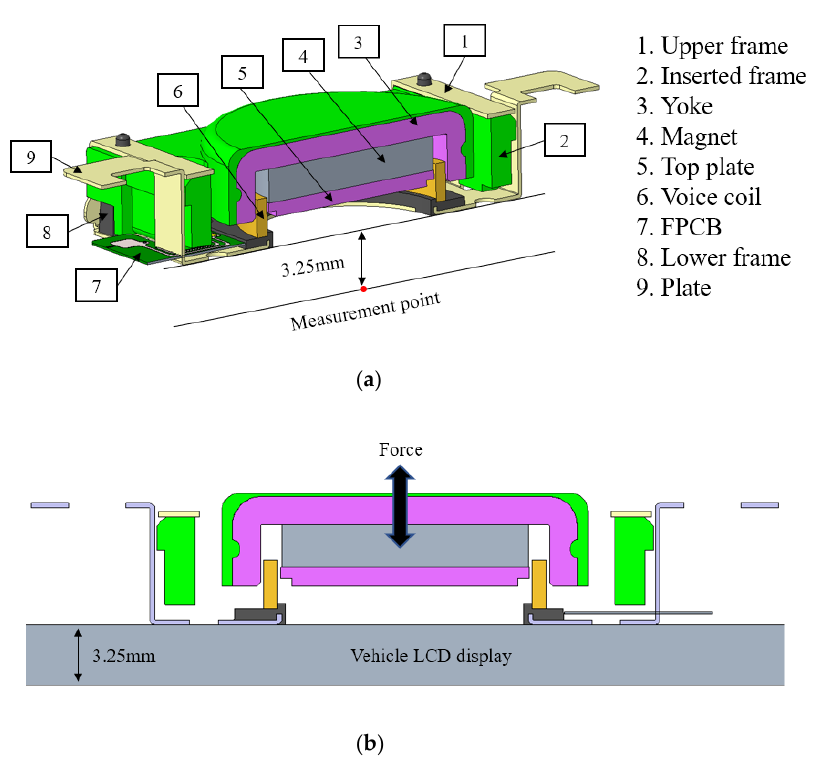
Figure 1. Prototype modeling: ( a ) the half modeling; ( b ) the two-dimensional view.